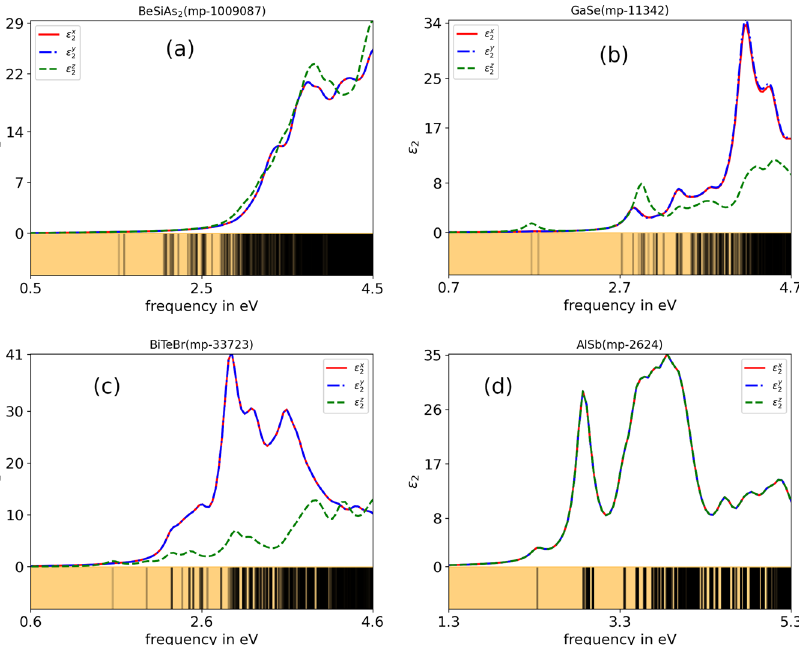
Fig. 4 The imaginary part of the dielectric function, ε 2 ( ω ), for light polarization along x (red), y (blue), and z (green) axis obtained from G 0 W 0 -BSE calculation for four selected materials. a BeSiAs (mp-1009087), b GaSe (mp-11342), c BiTeBr (mp-33723), and d AlSb (mp-2624). The yellow panel on the bottom of each fi gure shows the excitation energies with vertical